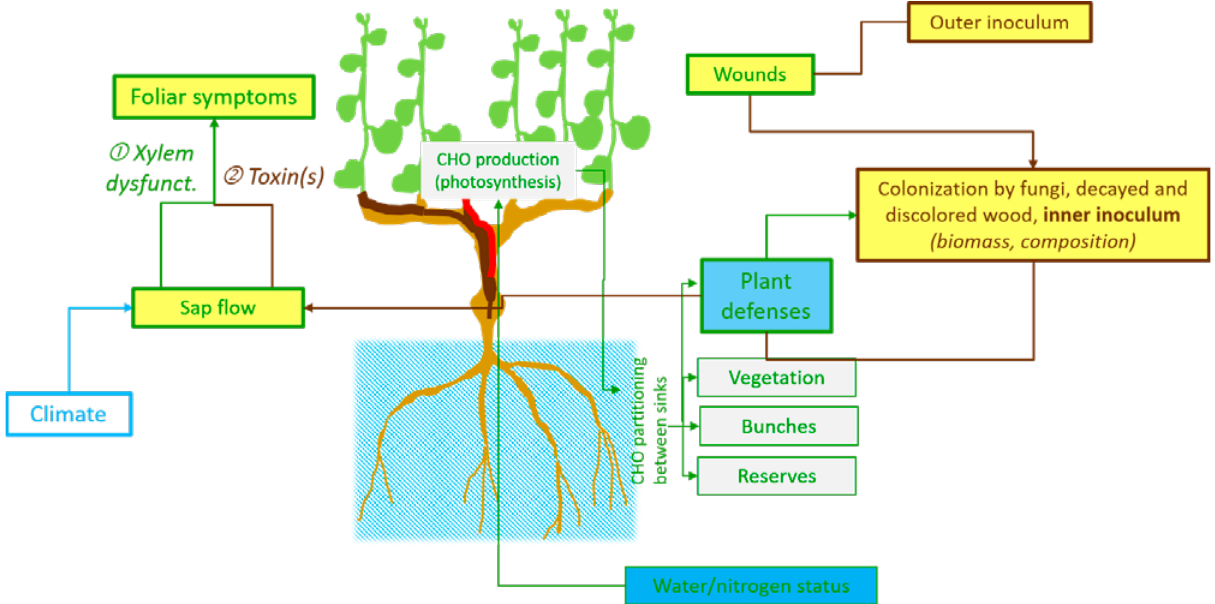
Figure 2. Investment in defences at the host/pathogen interface and probable implication of whole plant physiology: when pathology meets physiology. If foliar and wood symptoms cause direct losses for grapevine functioning, defence allocation will also be a probable expen- sive investment for affected vines, at the host/pathogen interfaces. This expense could be considered as a sink for C assimilates, like shoot growth, grape production or reserve replenishment. The role of trunk reserves (starch and derivatives) in supplying energy for local defenc- es in the wood is possible, but still to be investigated. Implication of vine balance in optimizing defence allocation would be an interesting direction for future research. CHO = Carbon, Hydrogen, Oxygen (C